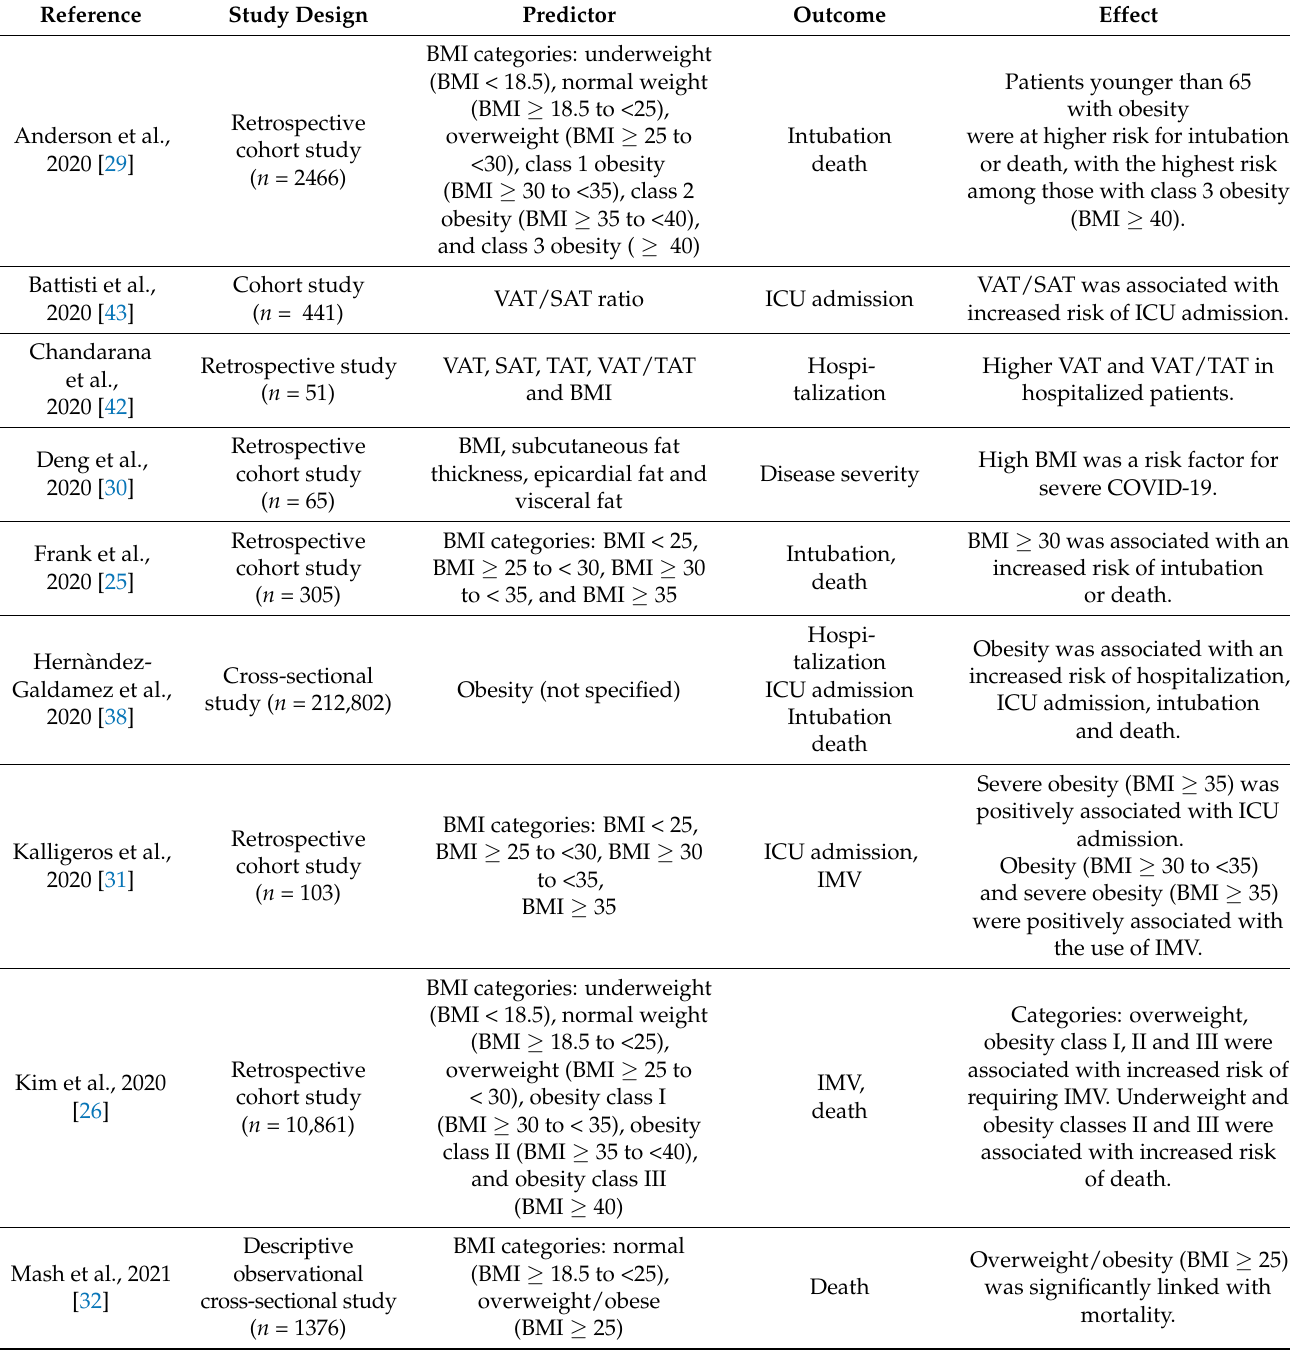
Table 1. Clinical Studies Investigating the Association Between Obesity and Disease Severity in COVID-19 Patients. Reference Study